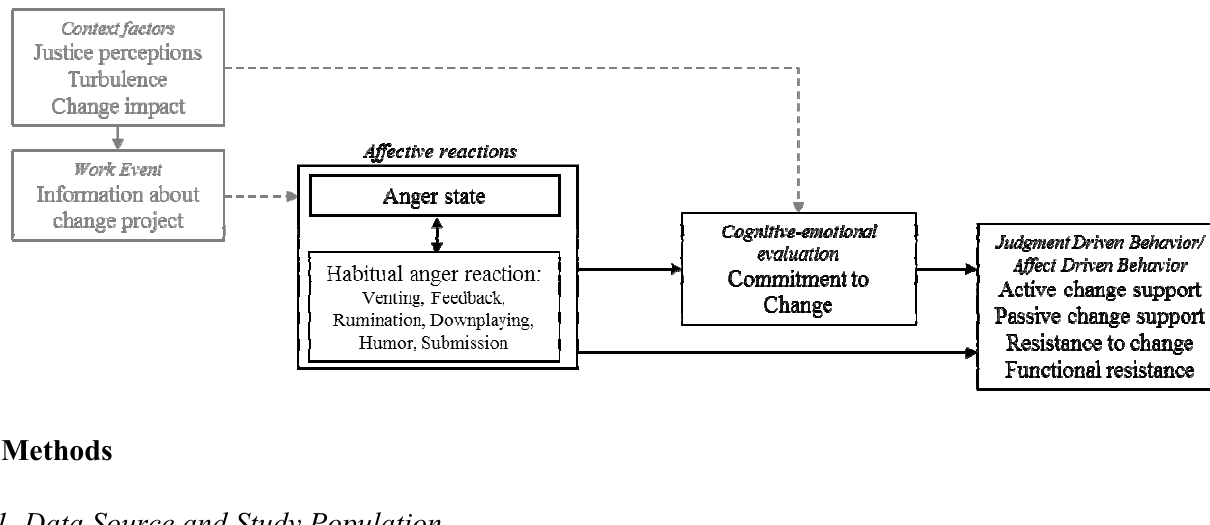
Figure 1. Integration of the hypotheses based on the redrawn AET-model (see [20],